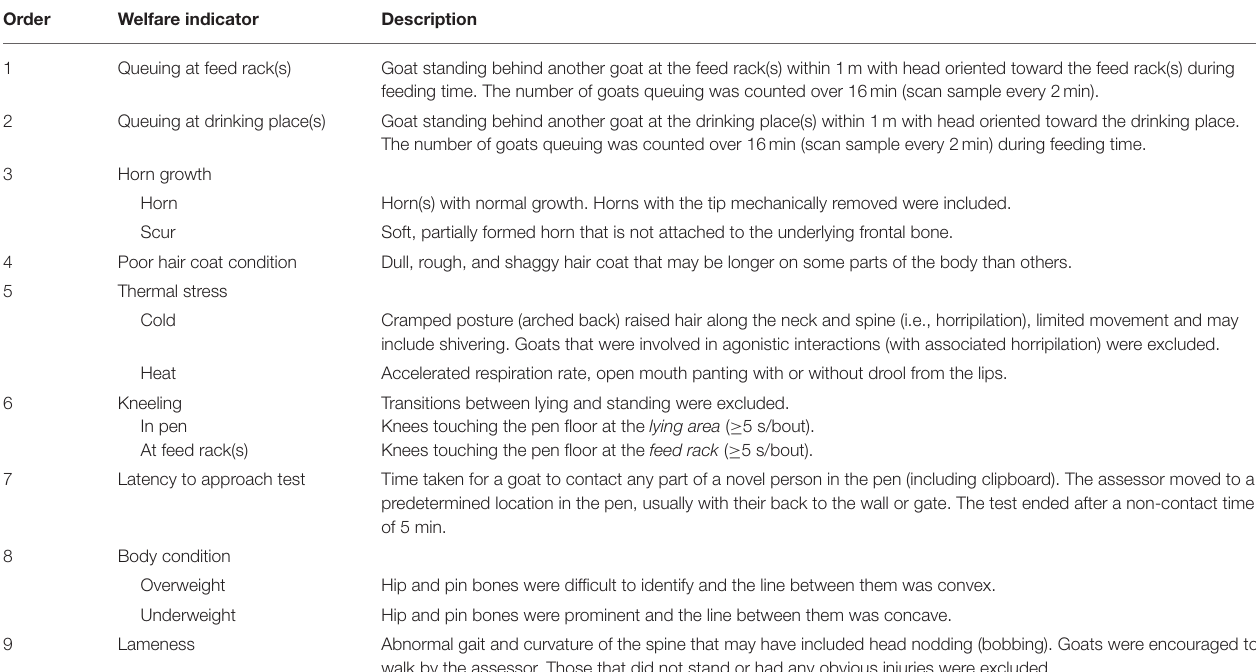
TABLE 2 | Descriptions of the group-level welfare indicators and the order of which they were assessed for the dairy goat welfare assessment protocol. Order Welfare indicator